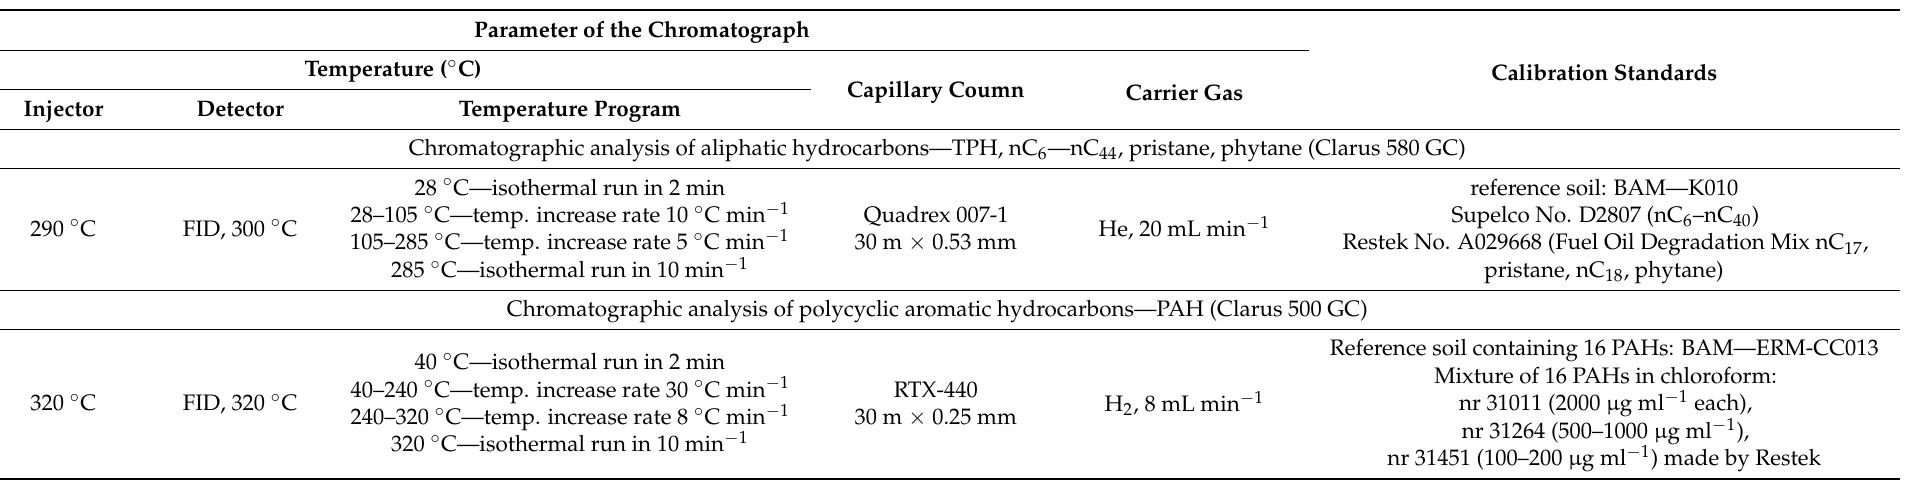
Table 1. Parameters of the chromatographic method for the determination of TPH and PAH on the Clarus 500 GC gas